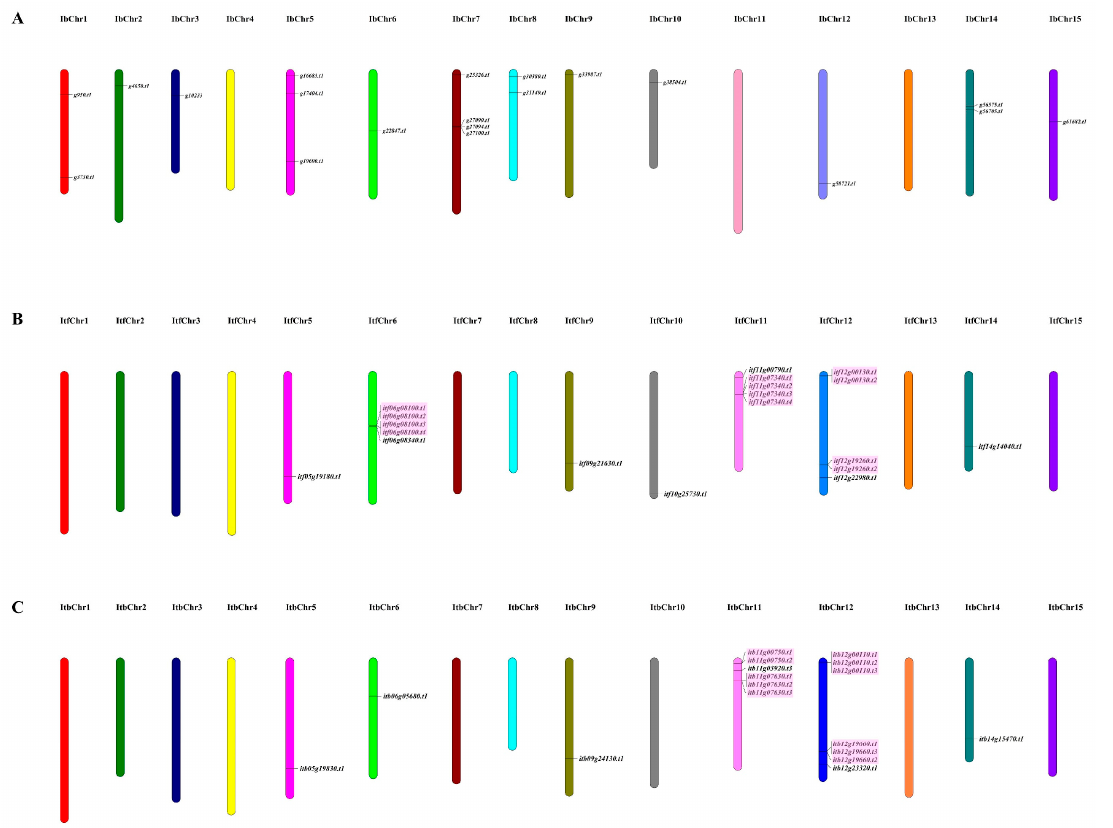
Figure 3. Distribution of nifH genes in chromosomes: ( A ) Distribution in I. batatas chromosomes. ( B ) Distribution in I. trifida chromosomes. ( C ) Distribution in I. triloba chromosomes. Randomly replicated nifH genes are shown with a pink background.